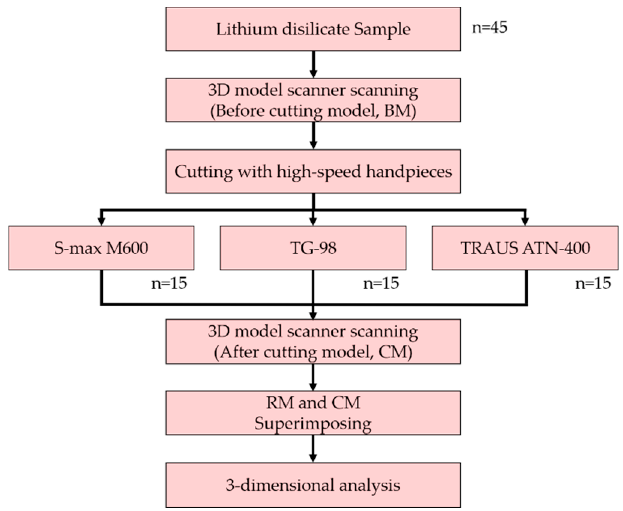
Figure 1. Experimental design for evaluating the cutting efficiency.